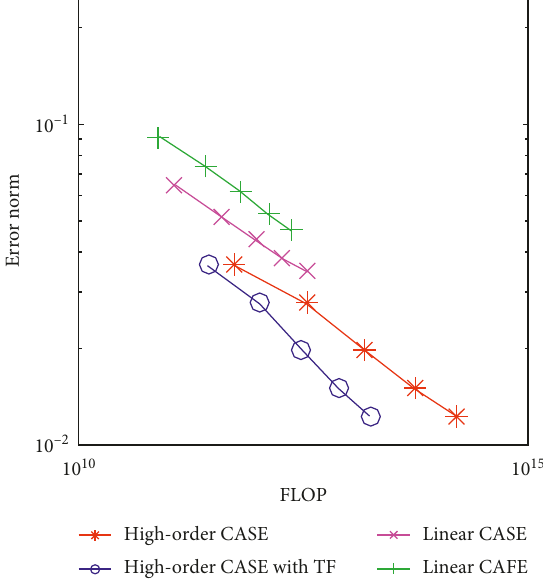
Figure 12: Operation count comparison for different element types with respect to FLOP.